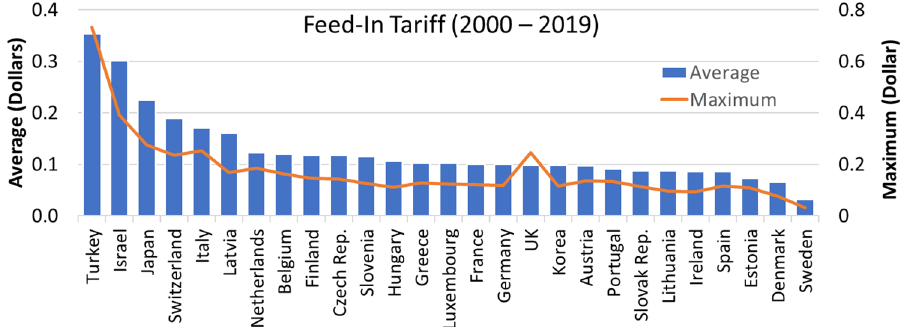
Figure 2. Feed-in tariff for wind energy by OECD countries.